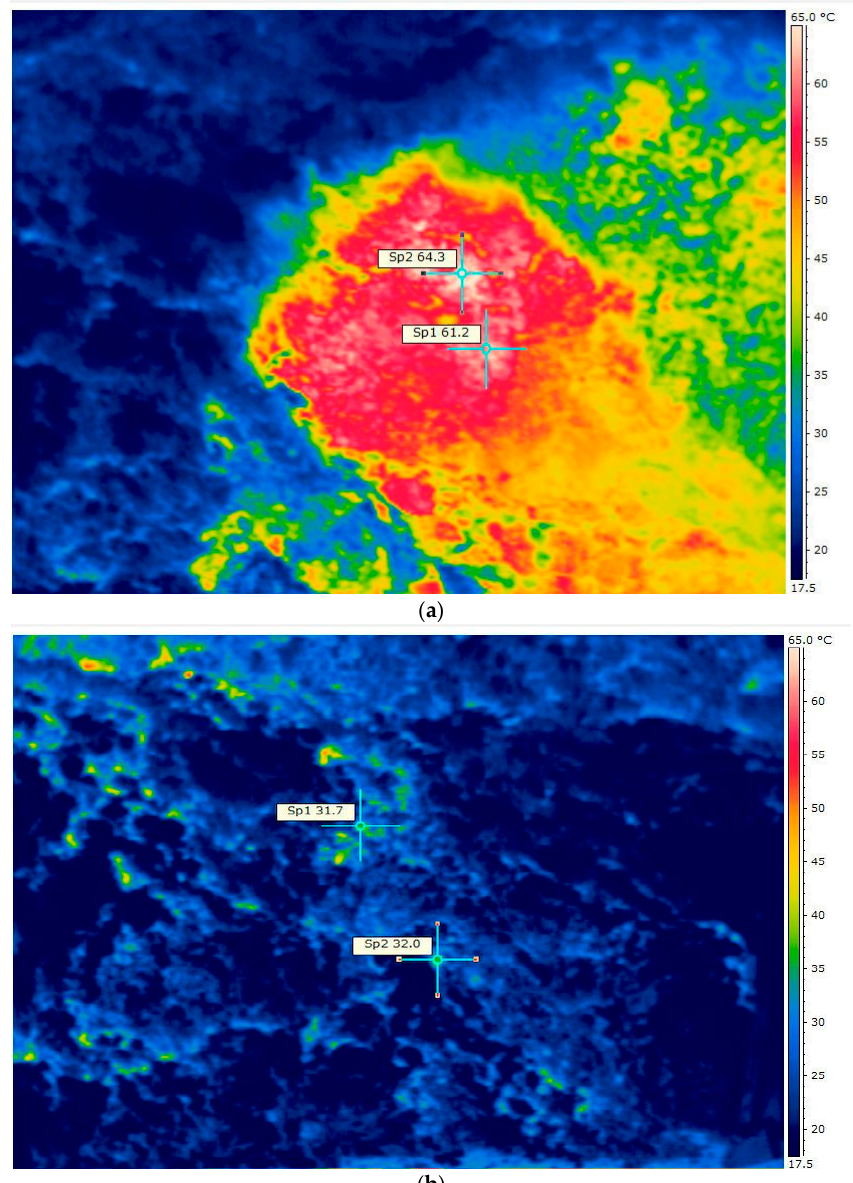
Figure 4. Exemplary thermogram of alternative fuel not subjected to the biodrying process (cross- Figure4. Exemplarythermogramofalternativefuelnotsubjectedtothebiodryingprocess(cross-section) section) ( a ), and subjected to biodrying ( b ). ( a ), and subjected to biodrying ( b